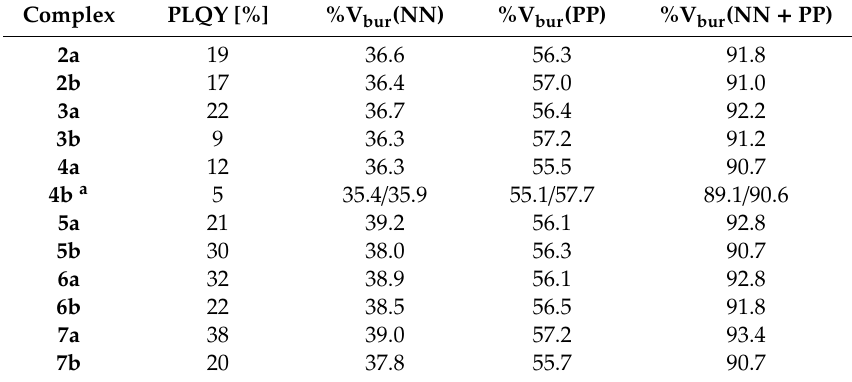
Table 1. Reported PLQY values for powder samples for Cu(I) complexes and %V bur for (NN), (PP), and (NN)(PP) units. Data are from reference [26].